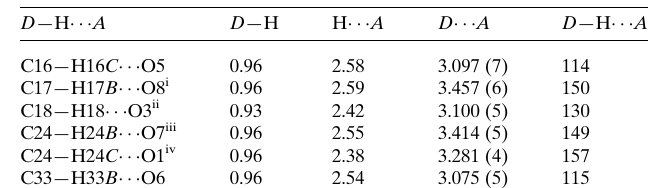
Table 1 Hydrogen-bond geometry (A˚ , (cid:3) ).